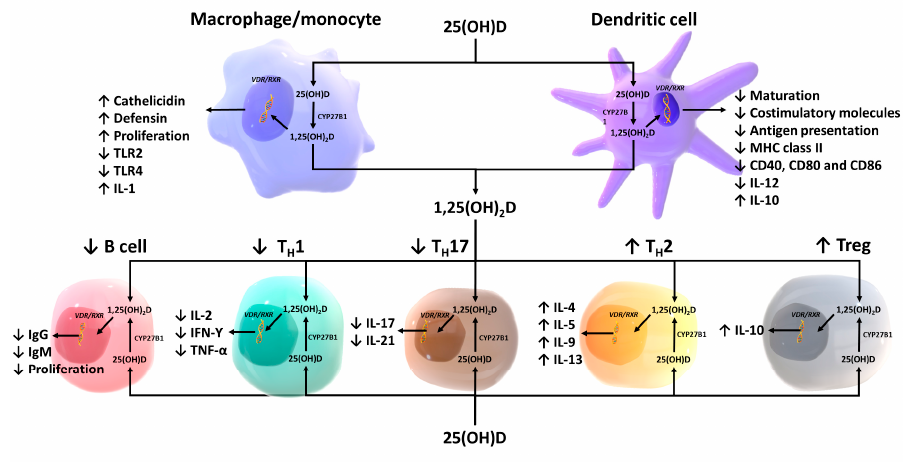
Figure 13. Schematic representation of paracrine and intracrine function of vitamin D and its metabo- lites and actions of 1,25-dihydroxyvitamin D on the innate and adaptive immune systems. Abbrevia-